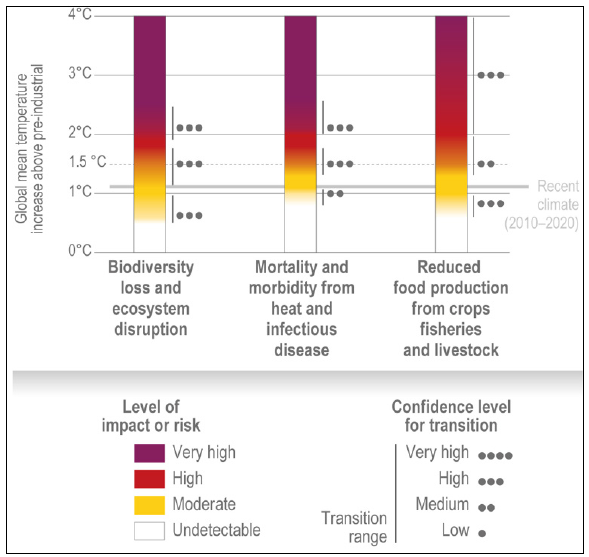
Source: Figure 9.6 in Chapter 9 of the WGII report. 1 Figure 1: Risks increase with rising levels of global warming, as shown in this ‘burning embers’ figure displaying selected key risks for Africa resulting from climate change. While specific assessments at country scale were not included in the WGII report, these risk levels are, in our opinion, a good representation of the South African